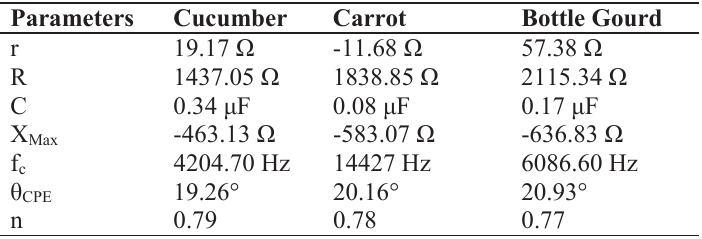
Table 5: Impedance data obtained from LEBISDI for a cucumber, a carrot and a bottle gourd.